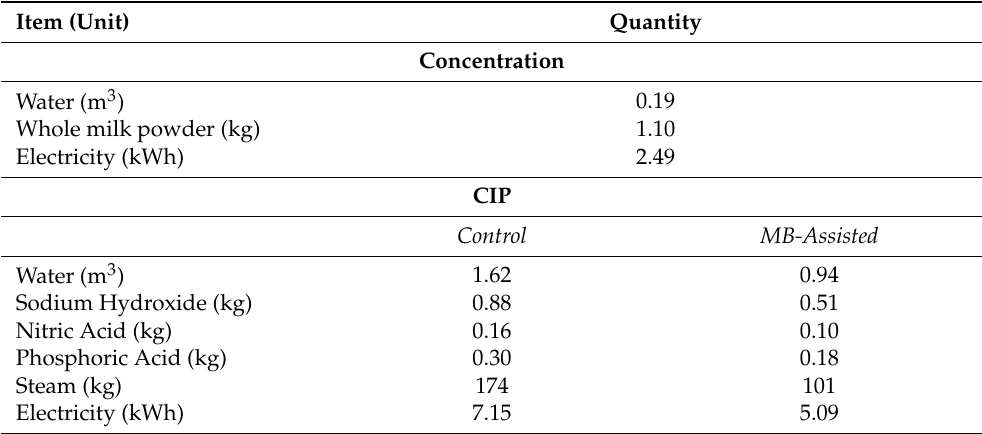
Table 3. Inventory (for one production cycle) of simplified concentrated milk